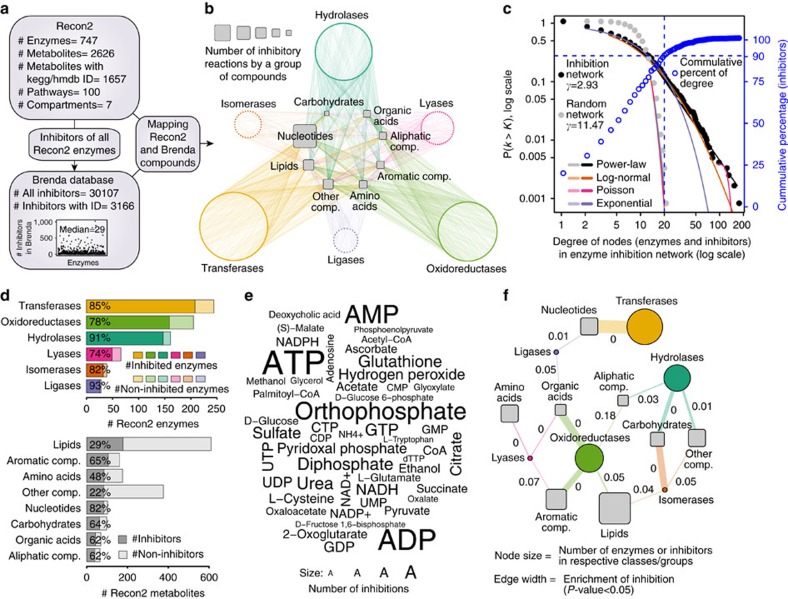
A genome-scale network of enzyme inhibition.(a) construction of a genomic-scale enzyme-inhibition network by mapping inhibitor information curated from the BRENDA database16, to the human metabolic reconstruction (Recon2 (ref. 17)). (b) enzyme-inhibition network (non-directional illustration), in which 82% of enzymatic reactions are inhibited by 26% of Recon2 metabolites. Enzymes are coloured and grouped according to enzyme commission (EC) category, inhibitors according to their HMDB chemical classification22, node size is scaled numerically. (c) The enzyme-inhibition network is scale-free, and follows a power-law and a log-normal distribution (P value for comparing power-law distribution with log-normal, Poisson and exponential are 0.36, 8.7e-05, 0.077 respectively), in comparison to a random network of the same size which is not scale-free (P value for comparing power-law distribution with log-normal, Poisson and exponential are 0.42, 0.78, 0.44, respectively). Ninety per cent of enzymes and metabolites have 20 or less connections (blue line). (d) Top: Enzyme classes (EC classifications) according to their occurrence in the genome, in relation to their representation in the inhibition network. Bottom: Metabolites categorized according to HMDB superclass22, and the percentage, and to which extent they are inhibitors in b. (e) Fifty most frequently inhibiting metabolites illustrated as word-cloud, scaled to the number of inhibitory interactions annotated for each inhibitor. (f) Enzyme classes are inhibited dependent on the metabolite’s chemistry. Size of the nodes is scaled according the number of inhibitor/enzymes within each class. The edge thickness is scaled according to the occurrence of significant inhibitory interactions between the inhibitor’s superclass, and enzyme class. Nodes are connected if P value<0.05. FDR values are highlighted over edges. Abbreviations refer to HMDB categories: Amino acids, Amino Acids, Peptides and Analogues; Aliphatic comp.,  Aliphatic Acyclic Compounds; Aromatic comp., Aromatic Cyclic Compounds; Carbohydrates, Carbohydrates and Carbohydrate Conjugates; Organic acids, Organic Acids and Derivatives; Nucleotides, Nucleosides, Nucleotides and Analogues.